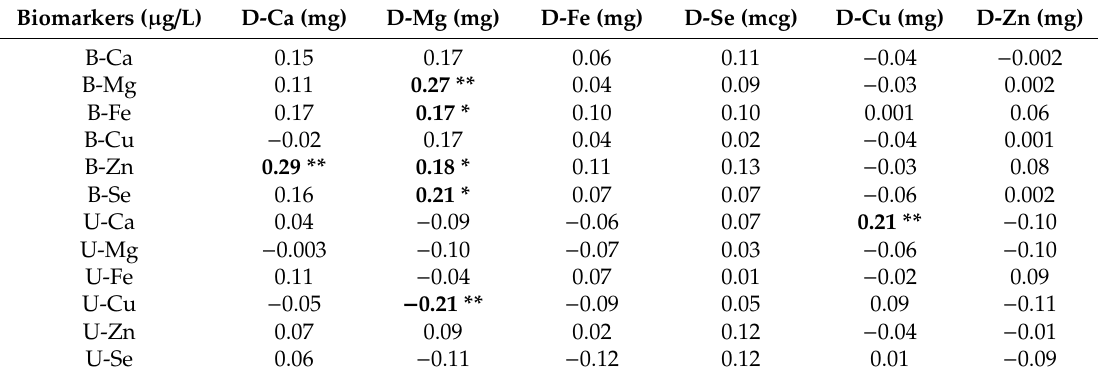
Table 4. Correlation coe ffi cients between dietary (D) micronutrient intake (top row) and micronutrient levels in blood (B) and urine (U) of e-waste recyclers (first column). Biomarkers ( µ g /